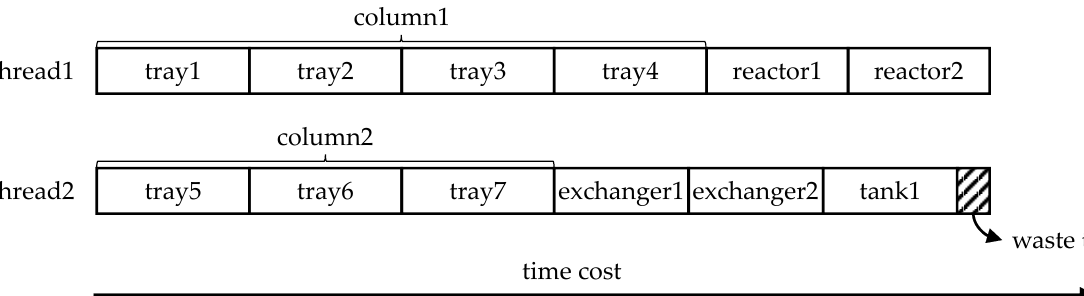
Figure 8. Waiting caused by imbalance task